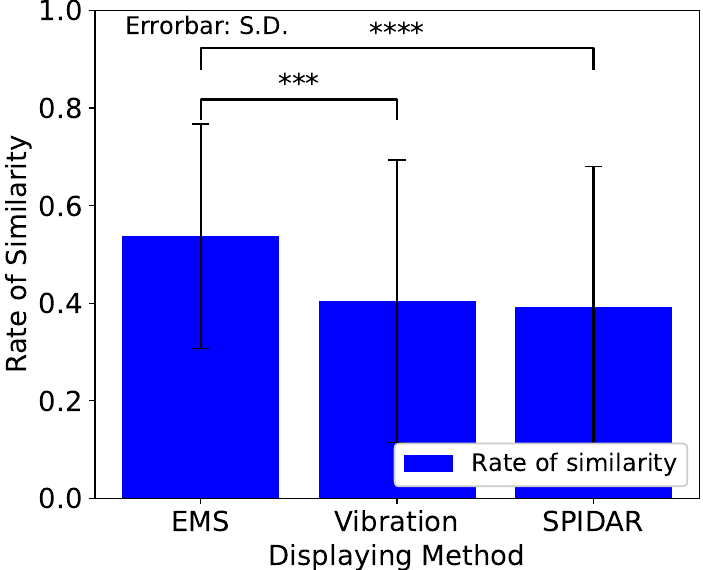
Figure 8. Overall results between methods; the vertical axis is the average similarity for each method. There were statistically significant differences between EMS and vibration and EMS and SPIDAR. *** and **** represent significance levels of 0.05%, and